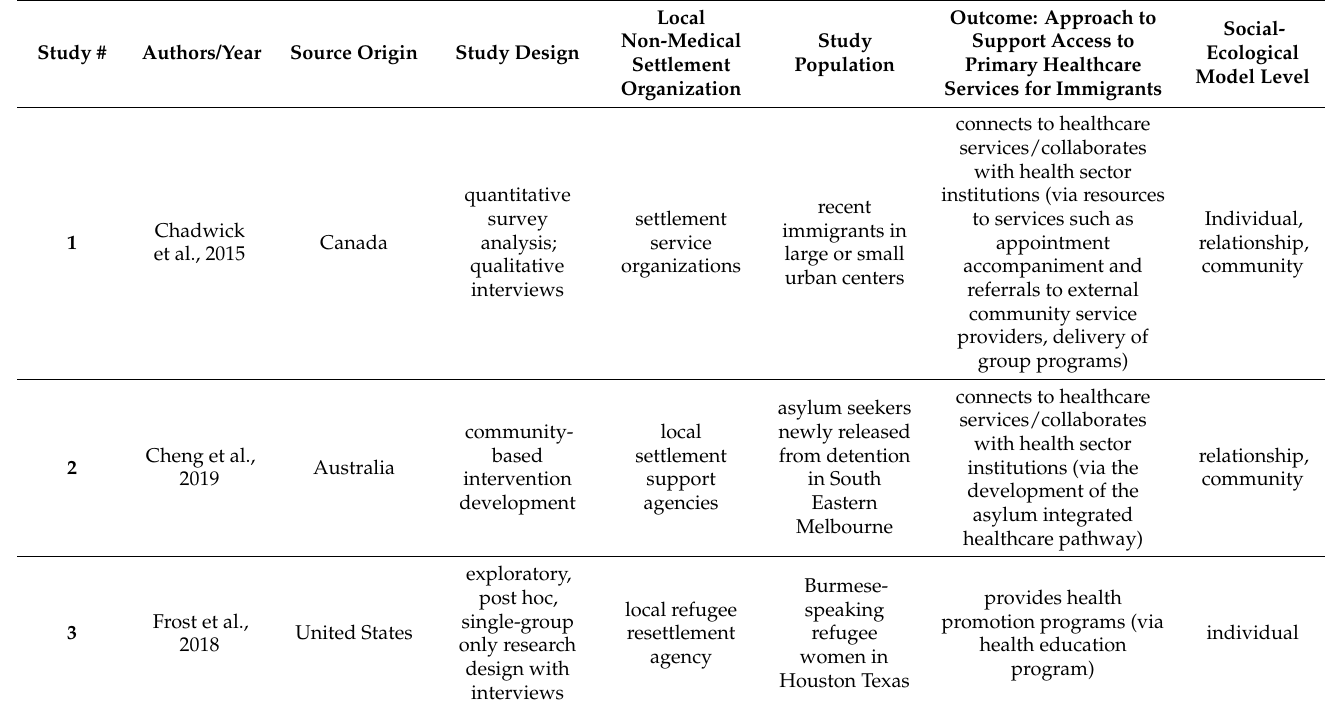
Table 2. Characteristics of included